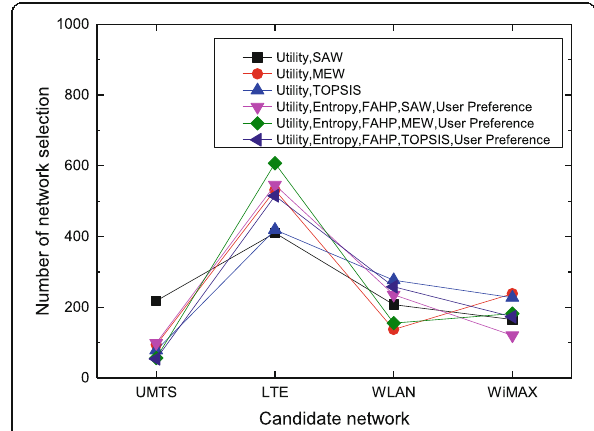
Fig. 14 Number of network selection of candidate networks for different algorithms for video application